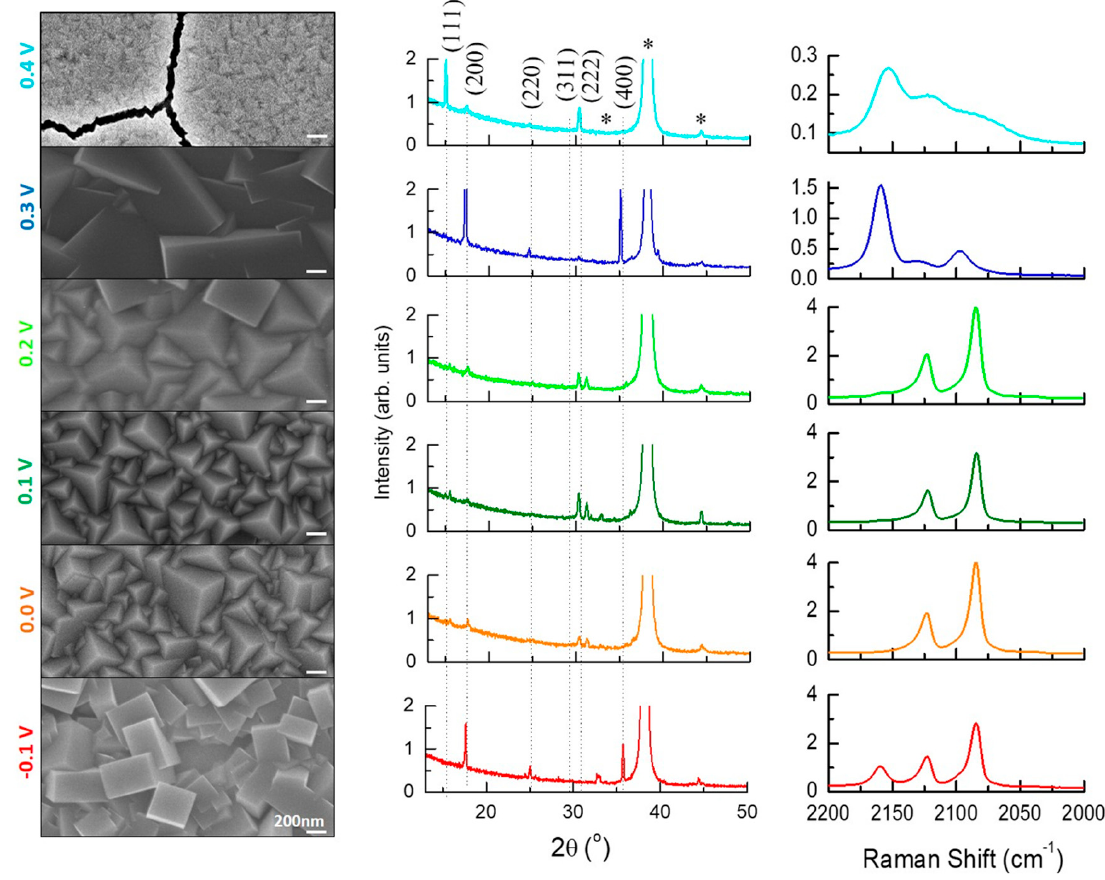
Figure 2. FEG–SEM images (column 1), XRD diffractograms (column 2), and Raman spectra (column 3) of thin films electrodeposited with 50 mC at 0.40, 0.30, 0.20, 0.10, 0.00, and − 0.10 V (from top to bottom). The peaks indicated by (*) are from the Au substrate. The dotted lines correspond to peak positions for the PB structure as obtained from the ICSD database code: 23102.